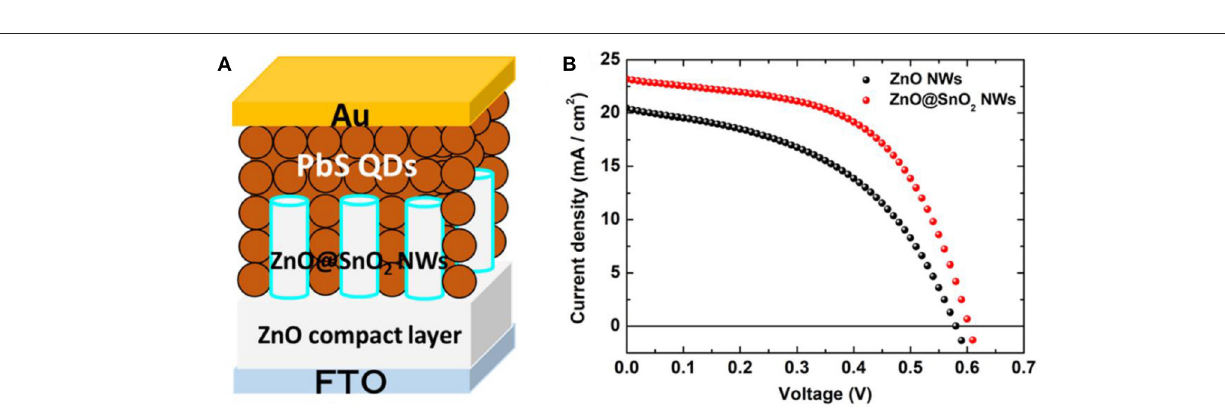
Frontiers in Energy Research |